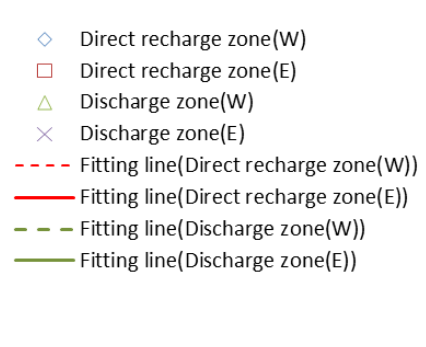
Figure 9. Correlation between the concentration of 3 H and major carbonate rock-related ions in karst water. ( a ) Correlation between the concentration of 3 H and Ca 2+ ; ( b ) Correlation between the con- centration of 3 H and Mg 2+ ; ( c ) Correlation between the concentration of 3 H and the ratio of Ca 2+ and Mg 2+ ; ( d ) Correlation between the concentration of 3 H and HCO 3 − .